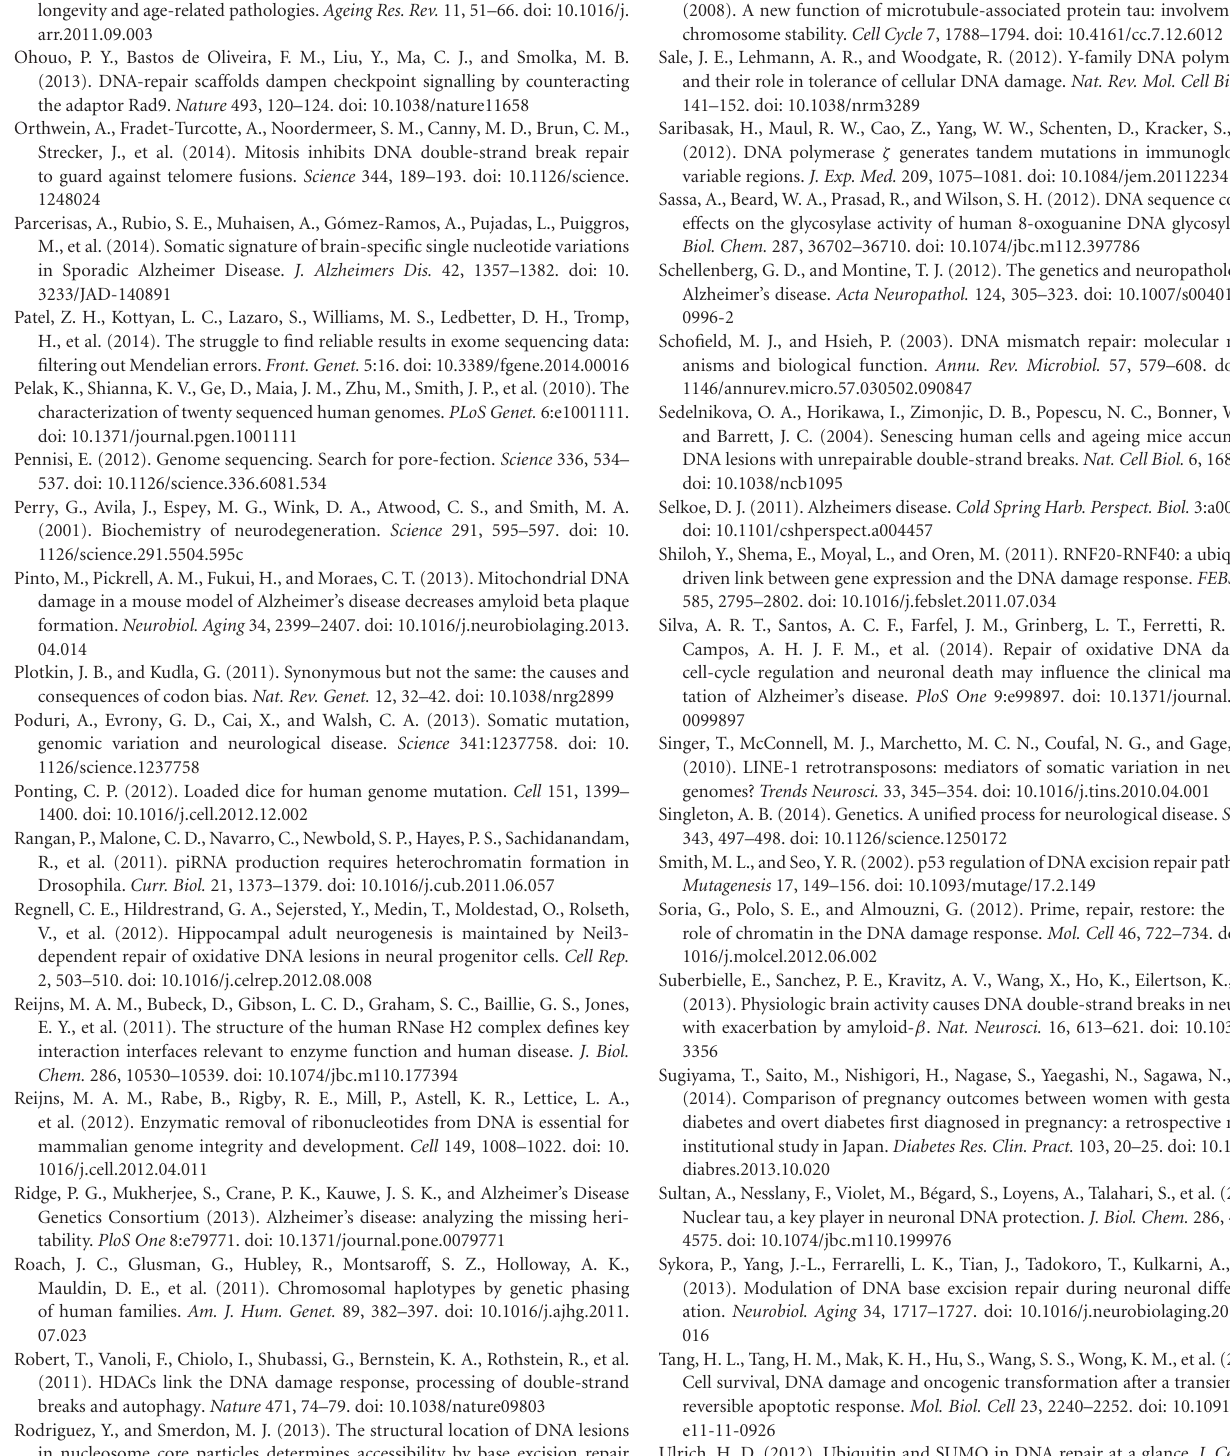
tability. PloS One 8:e79771. doi: 10.1371/journal.pone.0079771 Roach, J. C., Glusman, G., Hubley, R., Montsaroff, S. Z., Holloway, A.